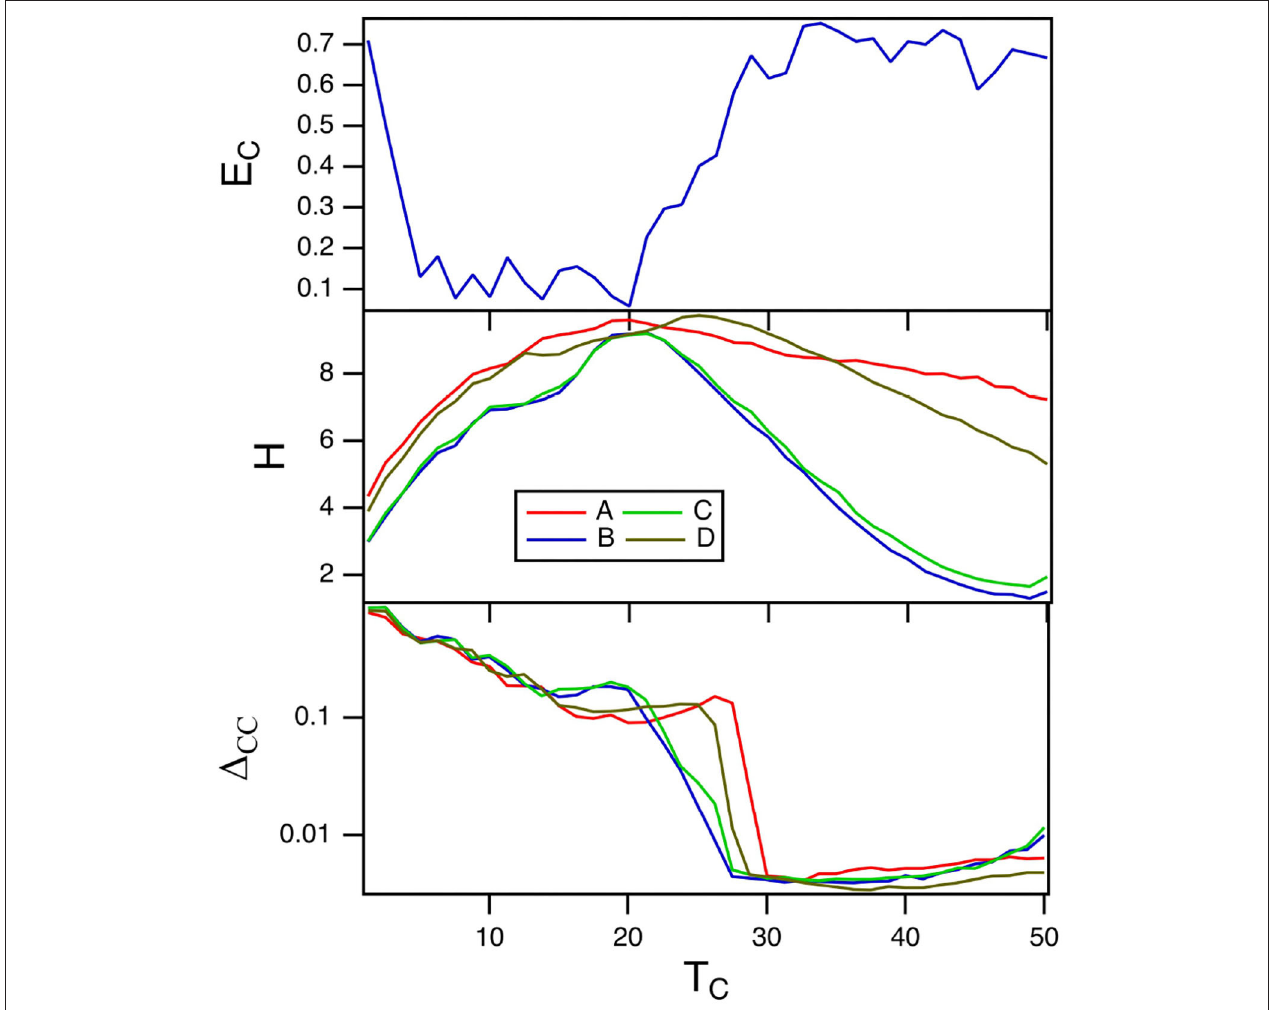
FIGURE 6 | The top plot shows the fraction of errors E C in identifying which of the four Sprott systems was present, as a function of the time constant T C for the spiking reservoir computer. The middle plot shows the entropies H for the four Sprott systems over the same parameter range. The bottom plot is the training error 1 CC . For this plot, γ = 0.004 and R τ =